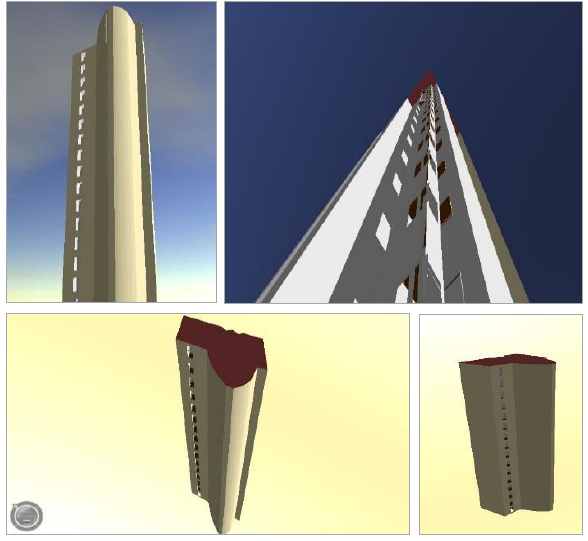
Figure 11. LoD4 CityGML building model showing openings